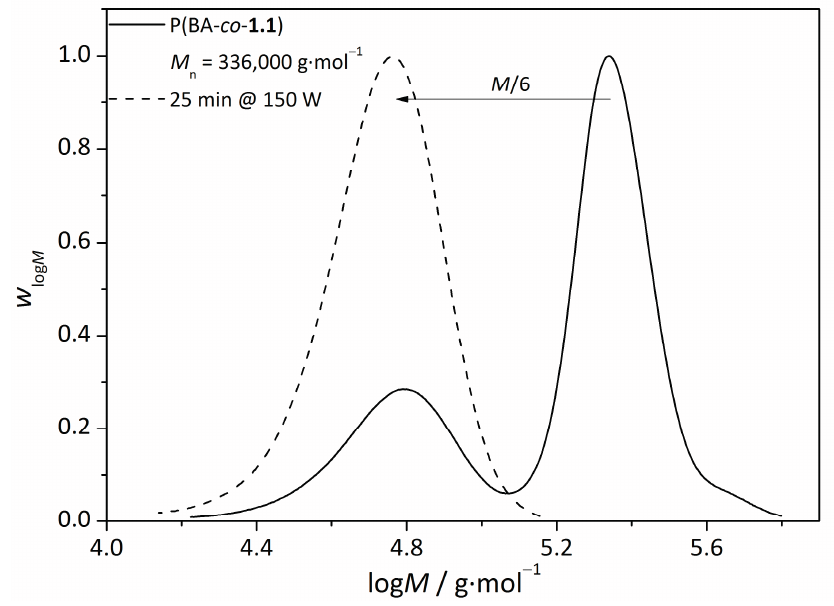
Figure 8. SEC-data, determined in THF, of a starpoly (BA- co - 1.1 ) with a molecular weight of 336,000 g·mol − 1 (solid line) and the resulting polymer ( M n = 50,000 g·mol − 1 ) after UV-irradiation (dashed line) for 25 min using a Laboratory-UV-Reactor System with a medium pressure mercury lamp of 150 W in ethyl acetate. The low molar mass portion of the original material (solid line) represents the individual arm polymer and stems from the RAFT star polymerization using a RAFT-agent cocktail consisting both of six- and mono-functional RAFT-agent (for details see text and reference